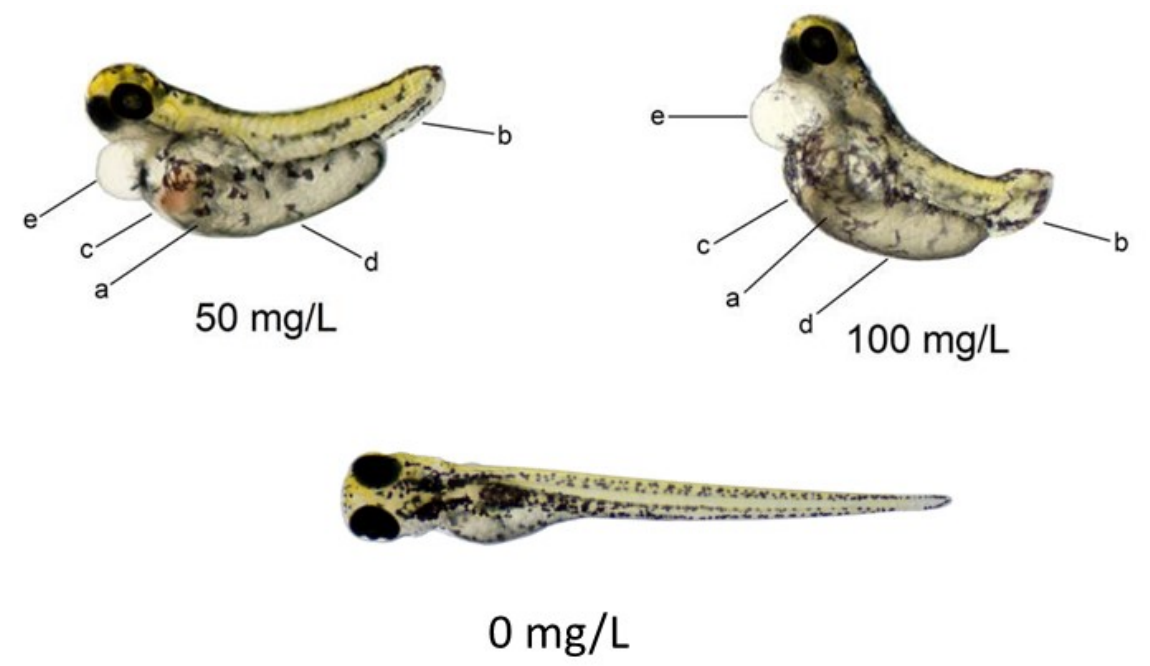
Figure 3 – The main embryo alterations found at exposures of 50 and 100 mg/L for 96 h. 0 mg/L control. a. yolk sac edema, b. tail malformation, c. stasis, d. yolk sac malformation, e. pericardic